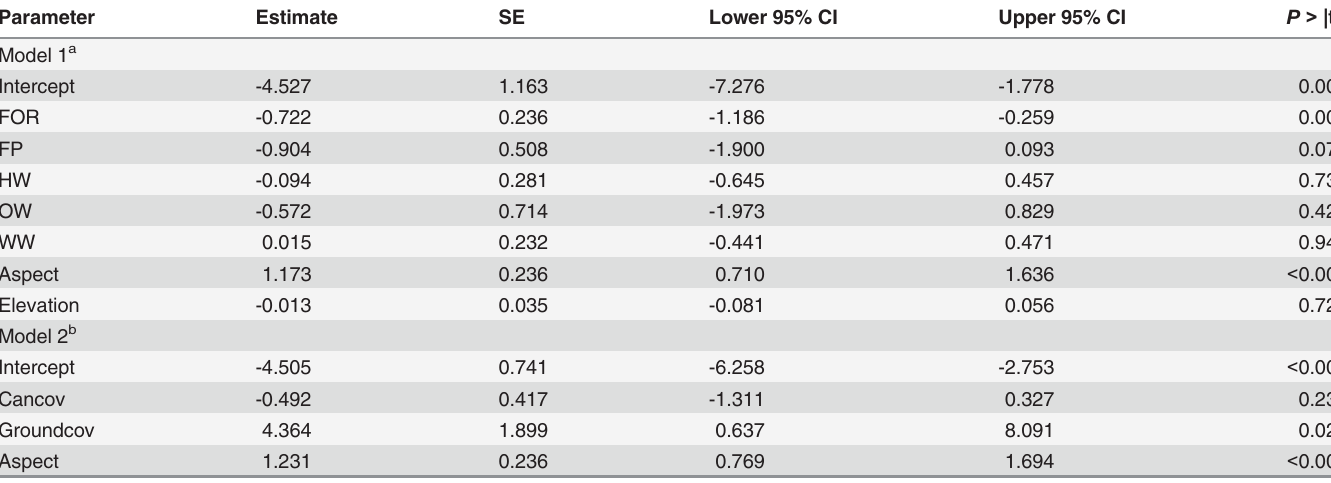
Table 5. Parameter estimates and 95% confidence intervals (CI) for top-ranking models of eastern diamondback rattlesnake habitat selection at the within-home range scale in the South Carolina Coastal Plain tidewater region.